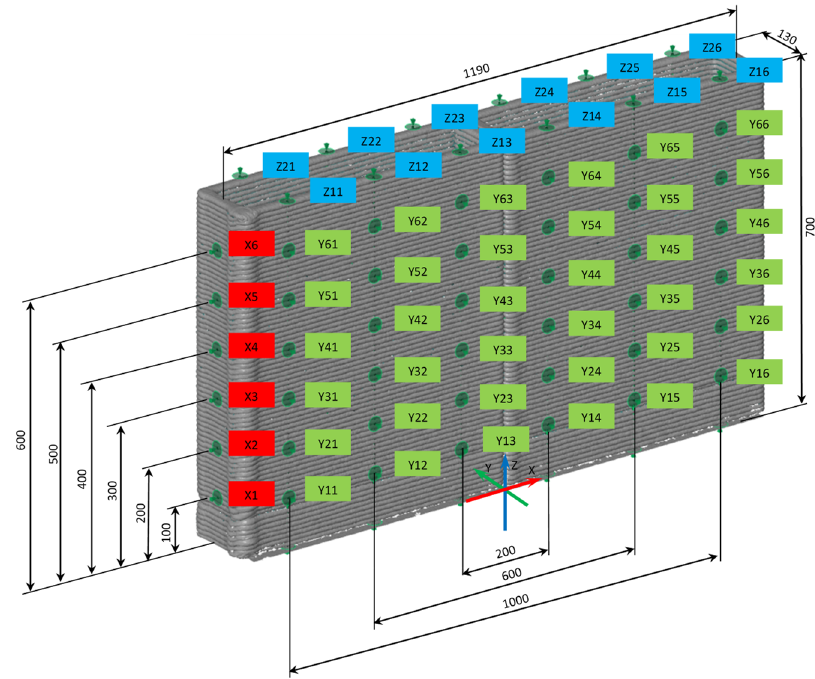
Figure 8. Marking the positions of measuring the dimensions of the “Caliper” function.